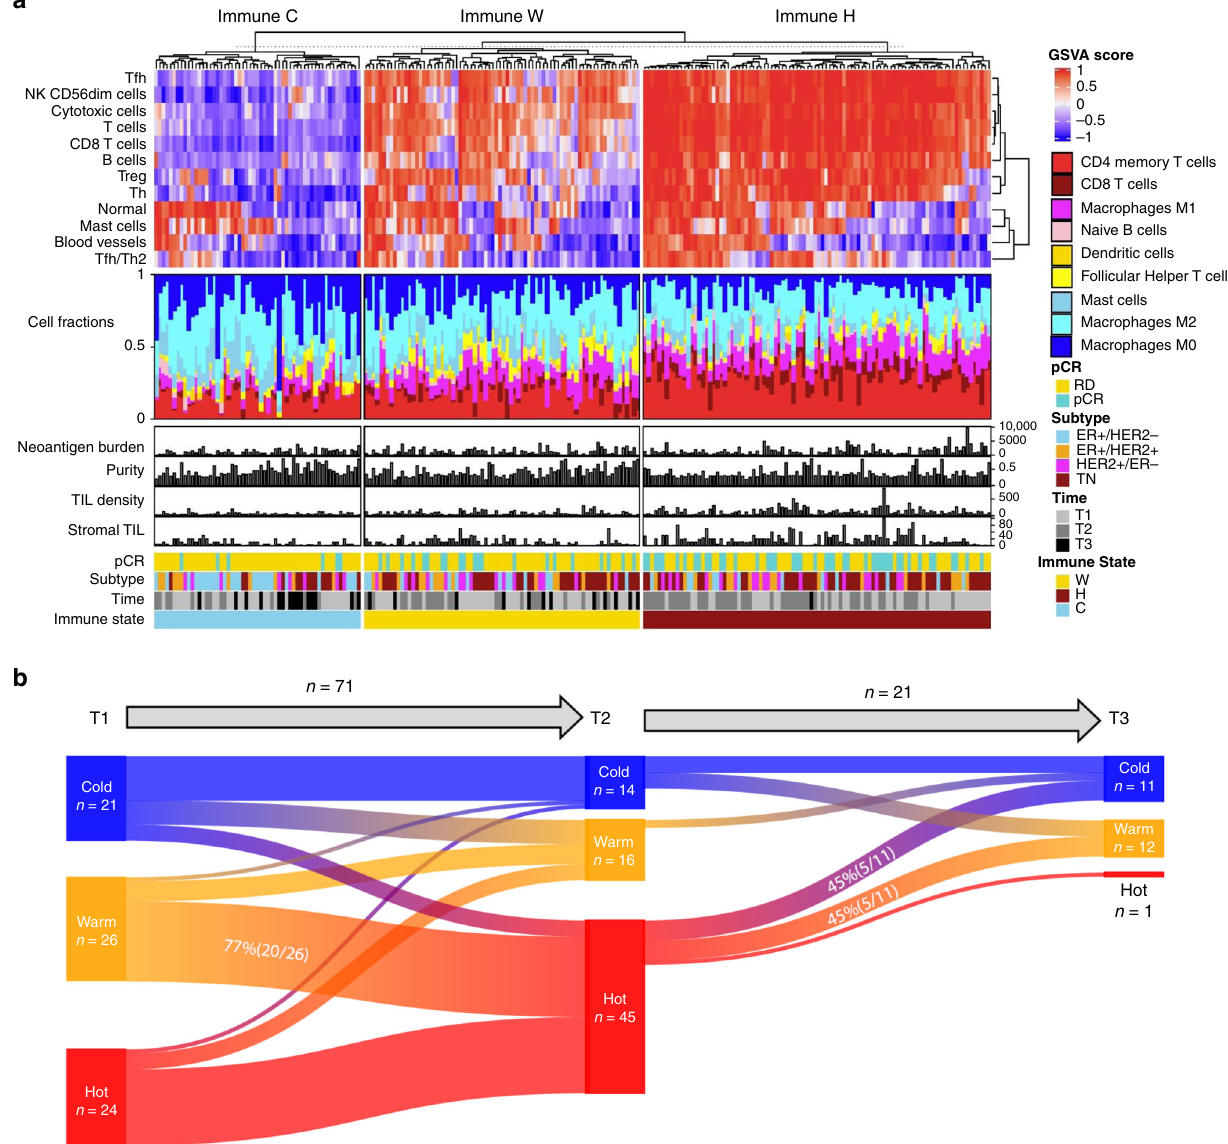
Fig. 5 Neoadjuvant chemotherapy induced dynamic changes in tumor associated immune states. a Integrated clustering of immune signatures and most abundant immune cell fractions. b Sankey plot of immune state changes from T1 to T2 and from T2 to T3. The text denotes the number of samples in each immune state and the percentage of samples that switch from one immune state to another. Source data are provided as a Source Data fi